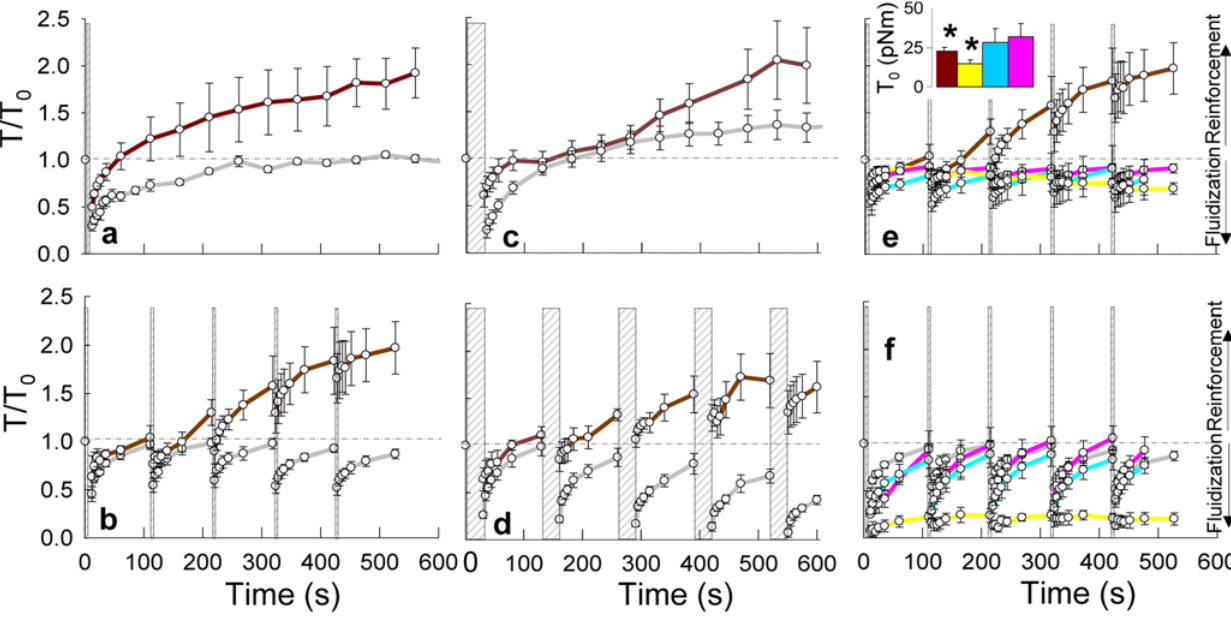
Figure 4. Homogeneous stretch induces fluidization; non-homogeneous stretch induces reinforcement. Traction as represented by the contractile moment T relative to the unstretched baseline value T 0 versus time, after stretch cessation. a, In response to both homogeneous biaxial stretch (gray; 10% strain magnitude, duration=4 sec, Table S1) and non-homogeneous stretch (brown; strain magnitude as in Figure 1 i, duration=4 sec), we observed prompt cytoskeletal fluidization. The subsequent recoveries, however, differed dramatically. While tractions after non- homogeneous stretch crossed and then exceeded baseline value by as much as 75% (p=0.017) at 600s, traction recovery after homogeneous stretch did not (p . 0.05). b, In response to a time series of repetitive transient stretches (Figure S1 b), non-homogeneous stretch (red) exhibited reinforcement while homogeneous biaxial stretches (gray; 10% strain magnitude) did not; the tractions after every homogeneous stretch cycle became progressively smaller and smaller. c,d In response to transient stretches of a longer time duration (duration=30 sec, Figure S1 c,d), qualitatively similar results were obtained. e, When cells were pretreated with 50nM phenylarsine oxide (PAO) (yellow), 10mM EGTA (pink) or 25 m M Gadolinium Chloride (blue) and subjected to a time series of repetitive non-homogeneous stretches (Figure S1 b) , no reinforcement was observed.